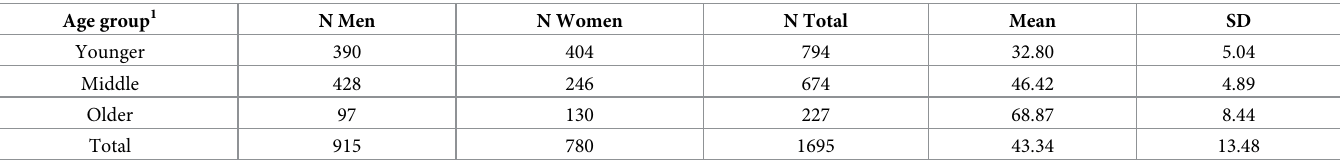
Table 1. Distribution of the interaction between age and gender in the Spanish sample. Age group